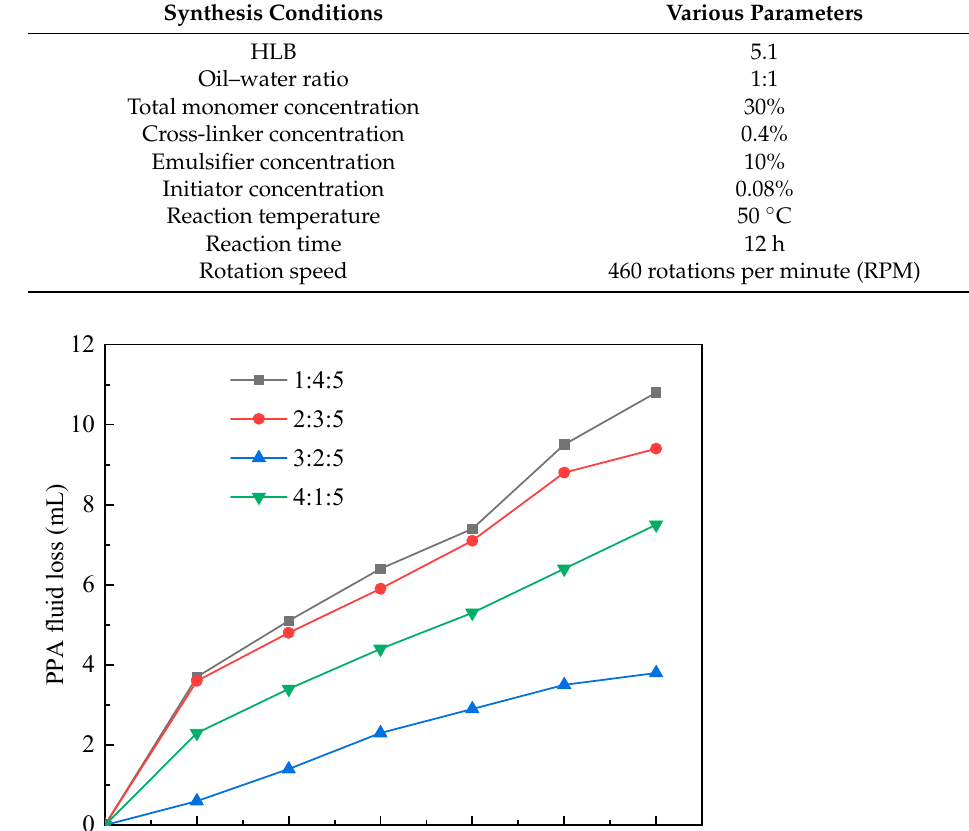
Table 3. The synthesis conditions of AMN other than monomer ratio.